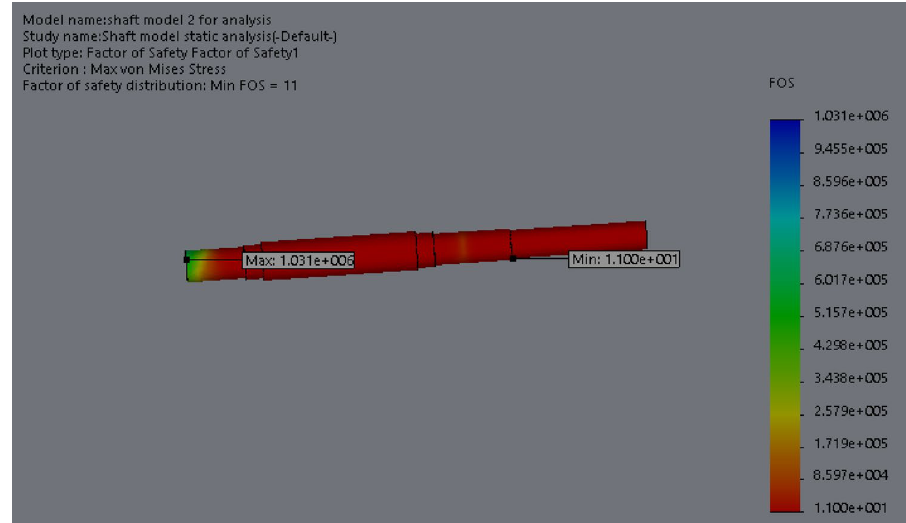
Figure 22. Plots of factor of safety.